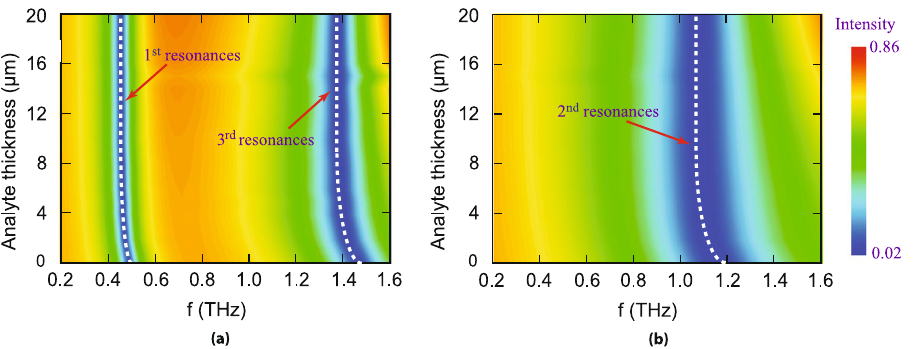
Figure 3. Contour plot of numerically simulated THz transmittance for different analyte thicknesses. Color bar shows the magnitude of transmission intensity. ( a ) Represents contour plot for polarization parallel to the split gap which clearly shows two blue colored regions around white dashed line for 1 st and 3 rd order resonances, respectively; ( b ) Depicts the same for polarization perpendicular to split gap i.e. for 2 nd order